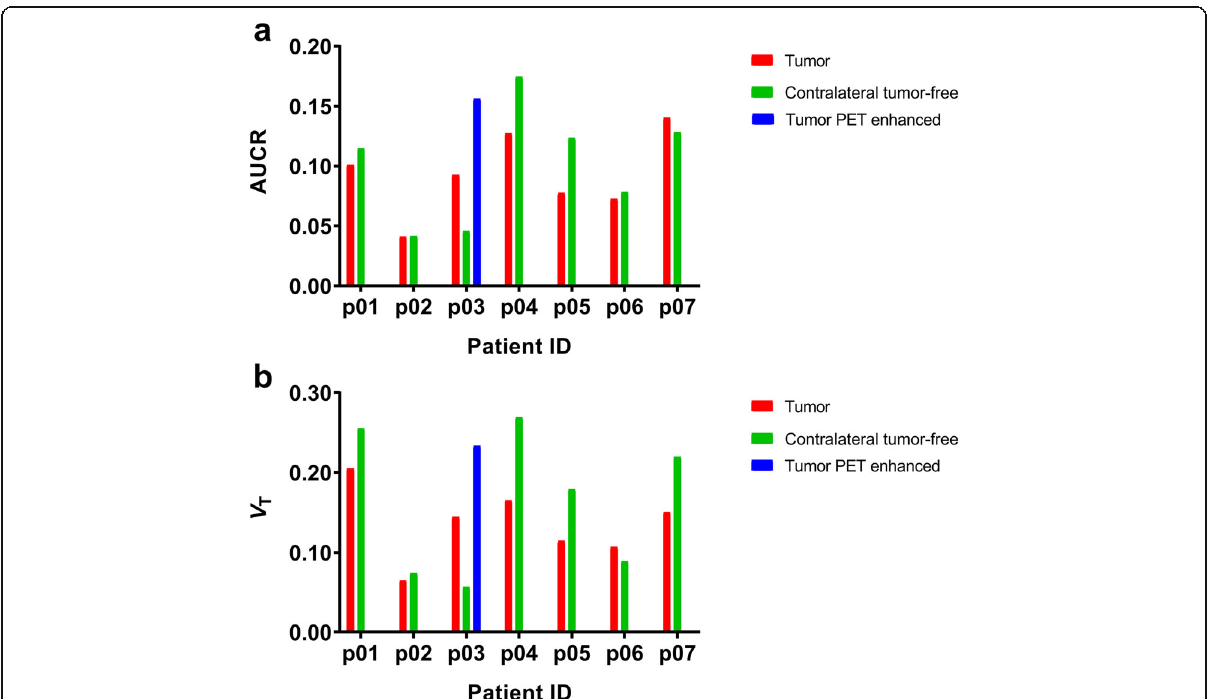
Fig. 2 Outcome parameters for [ 11 C]tariquidar brain distribution ( a AUCR, b V T ) in the tumor and contralateral tumor-free brain area (based on PMOD analysis). For p03, a tumor area with enhanced radioactivity uptake as compared with the rest of the tumor was visible (tumor PET enhanced)